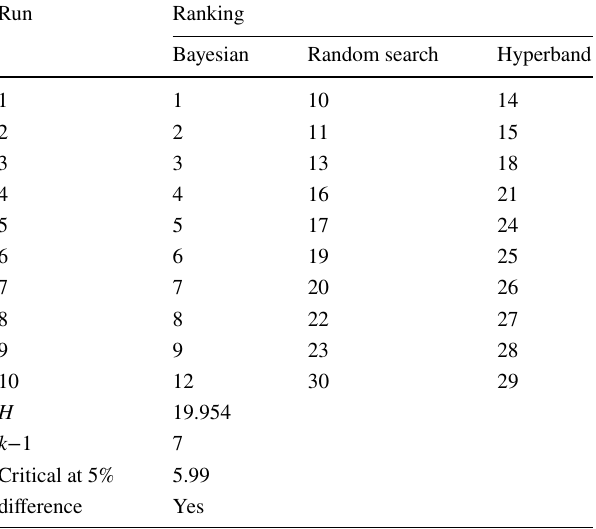
Table 3 Results from Kruskal–Wallis test